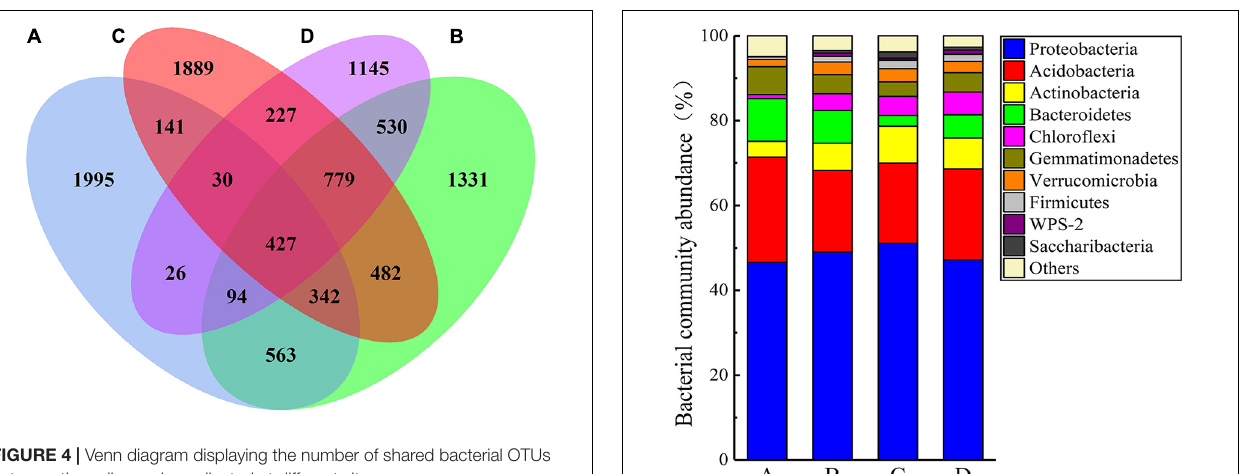
Frontiers in Microbiology |